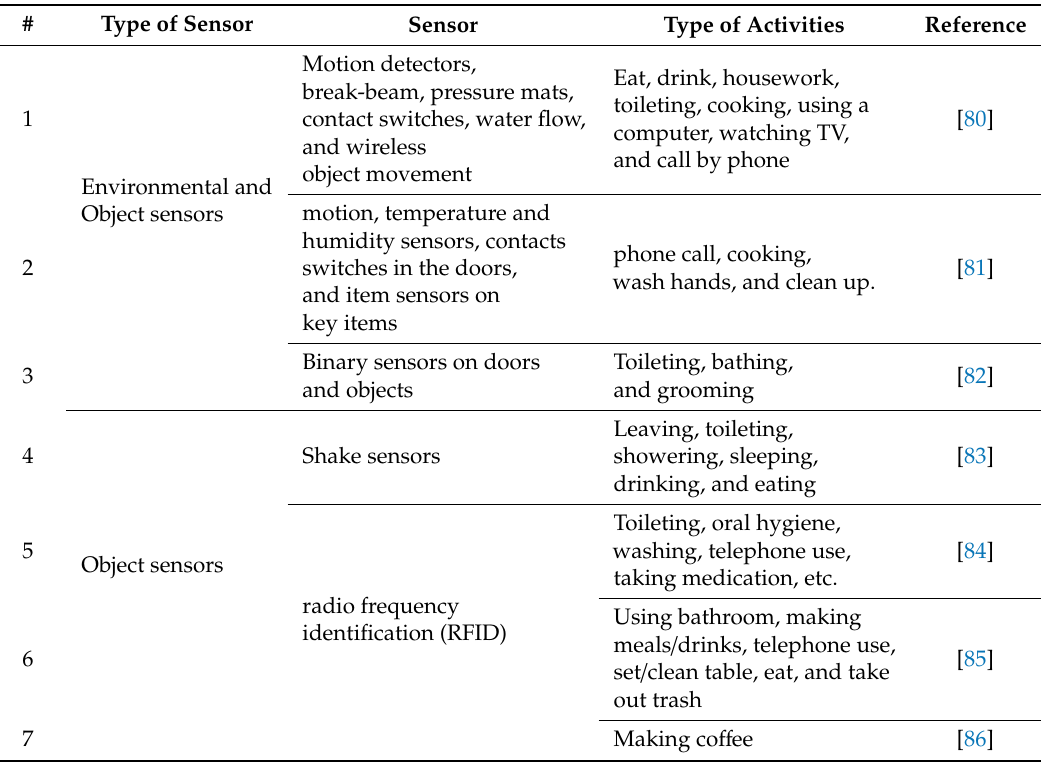
Figure 6. Environmental and object sensor representation related to activities of daily living (ADL). Table 3. Body sensor analysis.